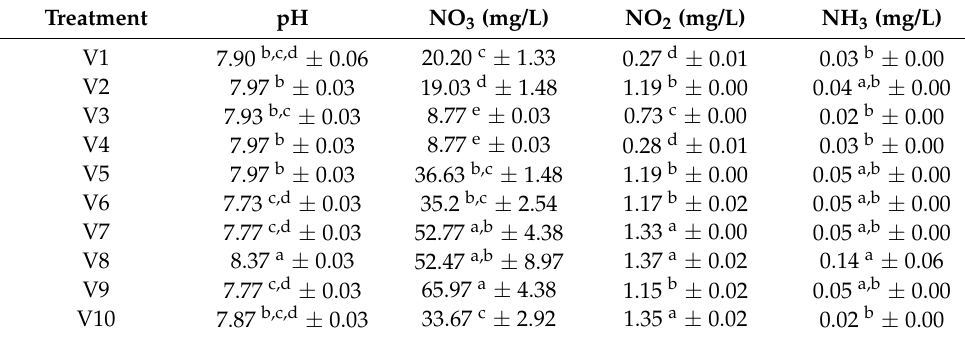
Table 6. Chemical composition of leachate.